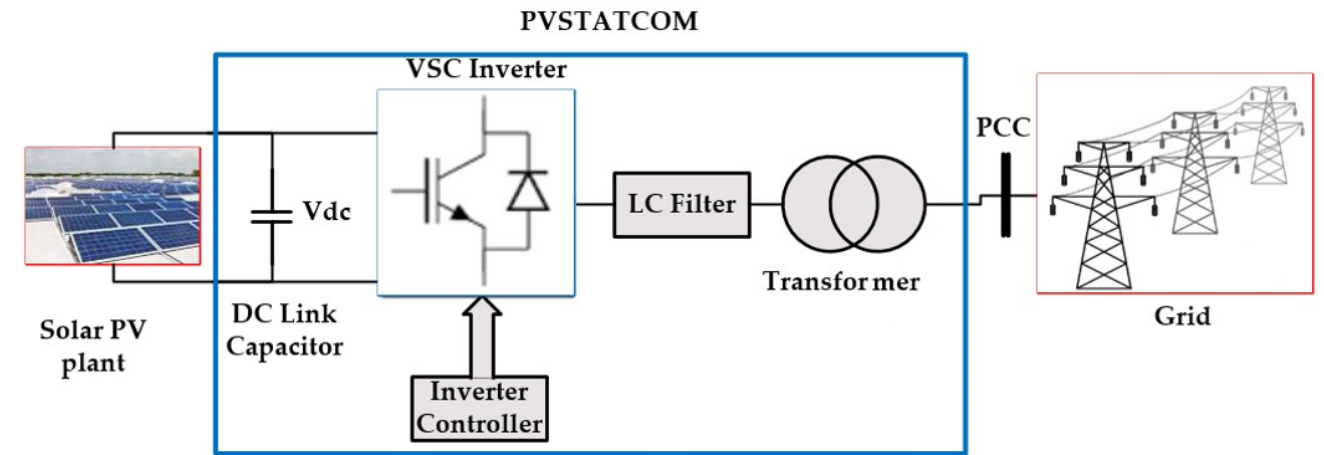
Figure 2. Configuration of PVSTATCOM device to be connected to an electrical power system [36].